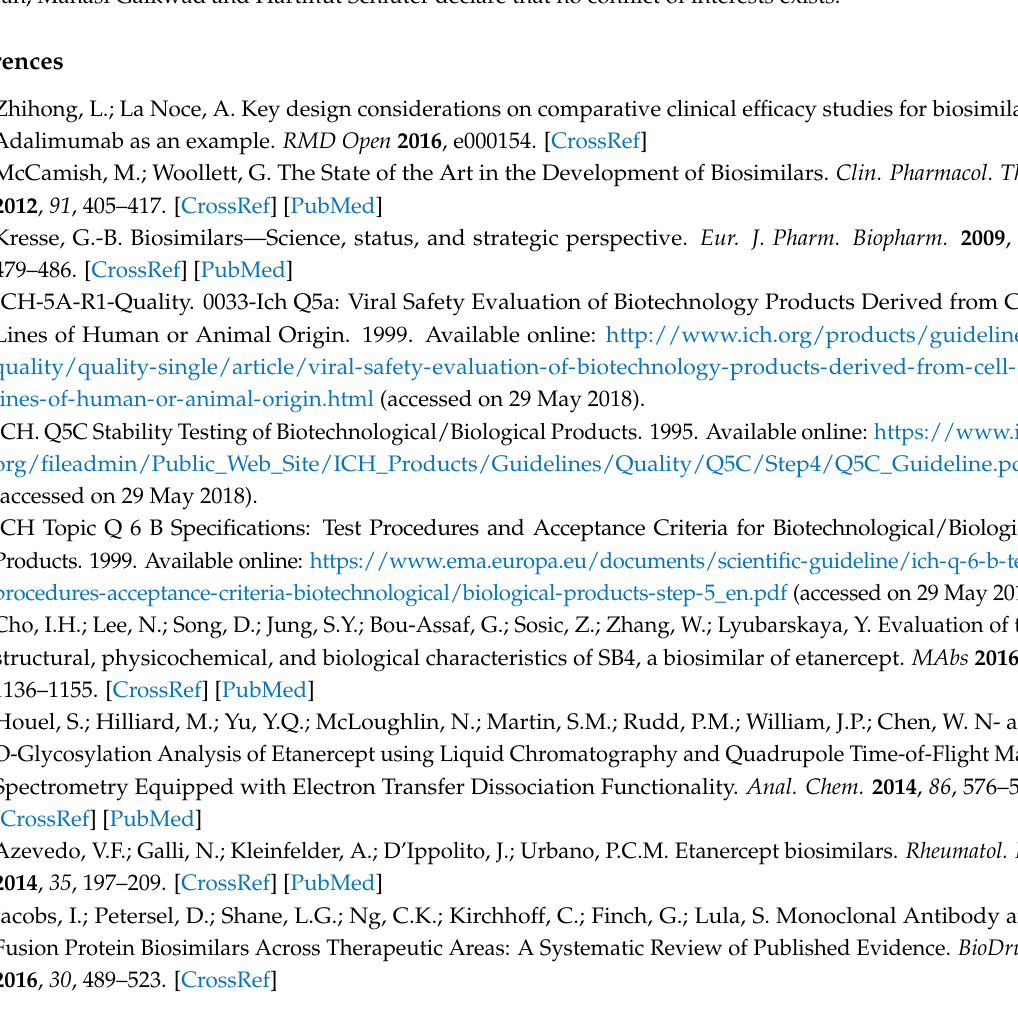
LysC and AspN digested peptides in Altebrel-6 is compared. Figure S3: TICs of different etanercept digested by A) trypsin B) AspN and C) LysC. Figure S4: Full MS1 and MS2 spectra of the (276)TPEVTCVVVDVSHEDPEVK(294) and (295)FNWYVDGVEVHNAK(308) peptide in Enbrel-G and Altebrel-8. Figure S5: Fragment spectrum of the glycopeptide containing the O-glycosylation site at O5 peptide with following the oxonium fragment ions (labeled by the full name) at MS2 level. Figure S6: MALDI-MS mass spectrum of permethylated N-glycans released from Enbrel-G. Figure S7: BPCs of permethylated N-glycans derived from different etanercept samples from two vendors. Figure S8: Chromatograms and spectra from N-glycans from Enbrel-G representing different isomers. Figure S9: BPCs of O-glycans from different vendors. Figure S10: Chromatograms and spectra of O-glycans from Enbrel-G showing different isomers. Figure S11: Single cycle kinetics graph of Altebrel-8 with the fitted model. Figure S12: Dose-response curves of (A) Control Enbrel-H1 and (B) Control Altebrel-8 versus the in-house reference standard. Table S1: List of observed modifications in etanercept. Table S2: Identified N-glycans in